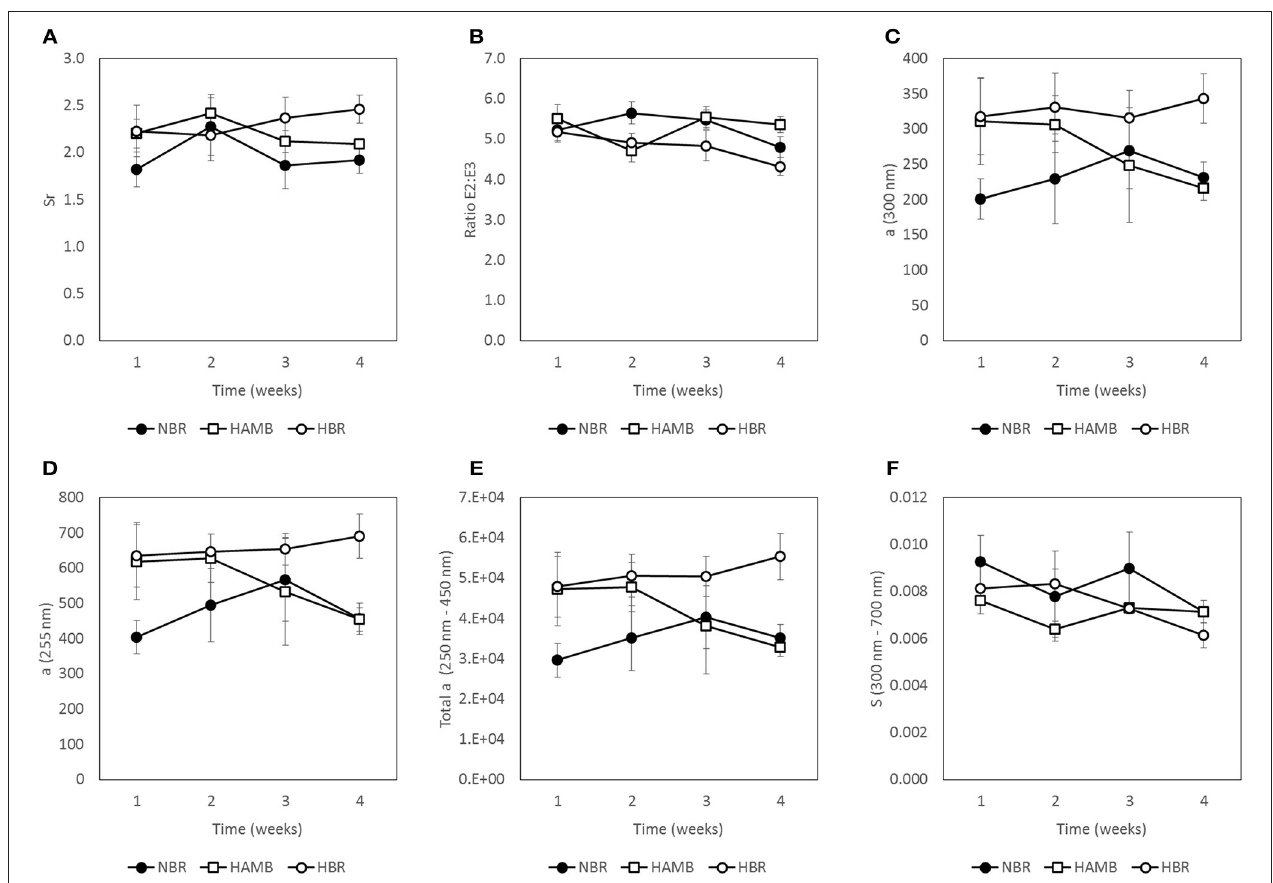
FIGURE 5 | Changes in molecular weight indices (MWI) of fecal samples during run-in (week 1) and subsequent 3-week experimental phase: Sr = ratio of absorption slopes between 275–295 and 350–400nm slope (A), E2:E3 = ratio between absorption coefficients at 250nm and at 365nm (B) , a (300 nm) = Napierian absorption coefficient at 300nm (C) , a (255 nm) = Napierian absorption coefficient at 255nm (D) , Total a = integrated absorbance between 250nm and 450nm (E) and S = spectral slope of absorbance from 300 to 700nm (F)